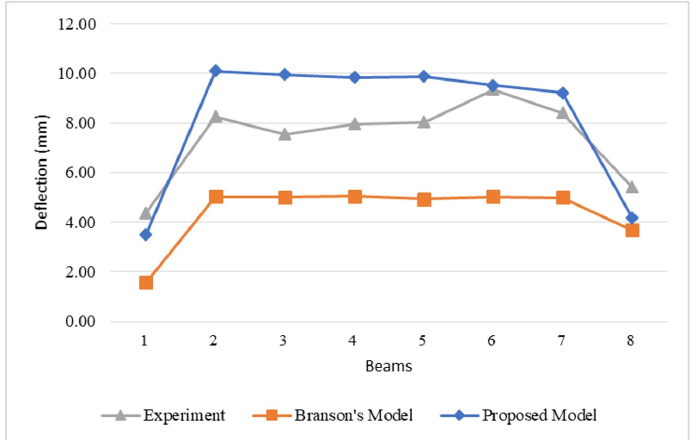
Figure 8. Beams with reinforcement rate from 0 to 1%.